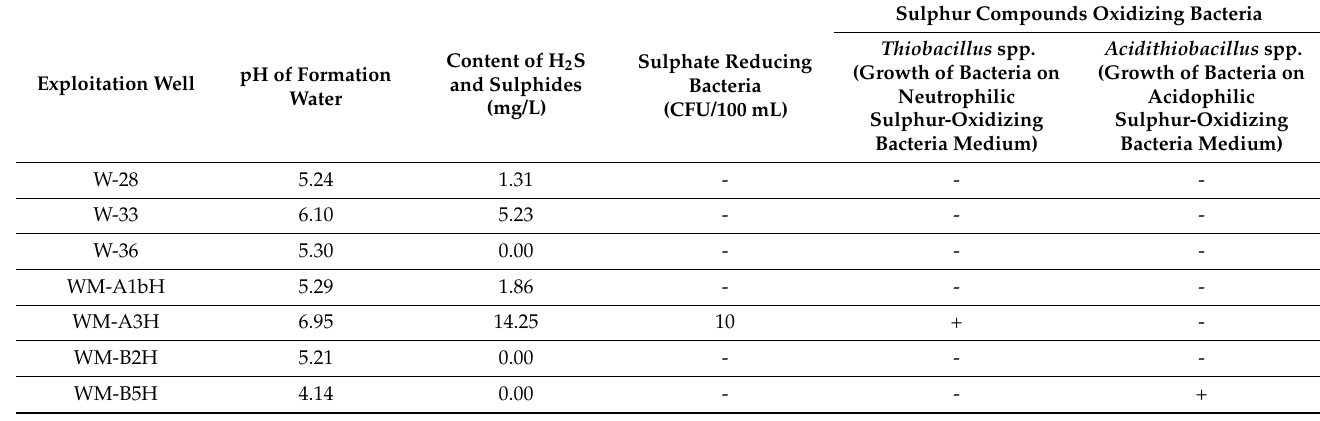
Table 4. The results of microbiological and chemical tests on formation waters collected from Wierzchowice UGS wells—XIX operational cycle